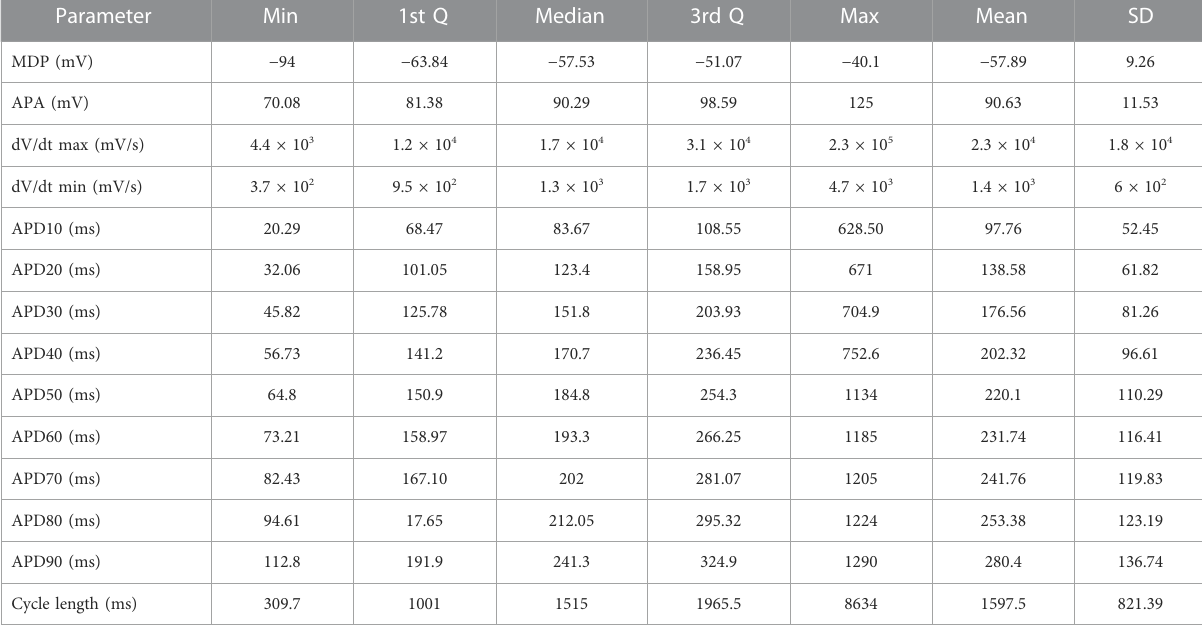
TABLE 1 Descriptive statistics for the entire